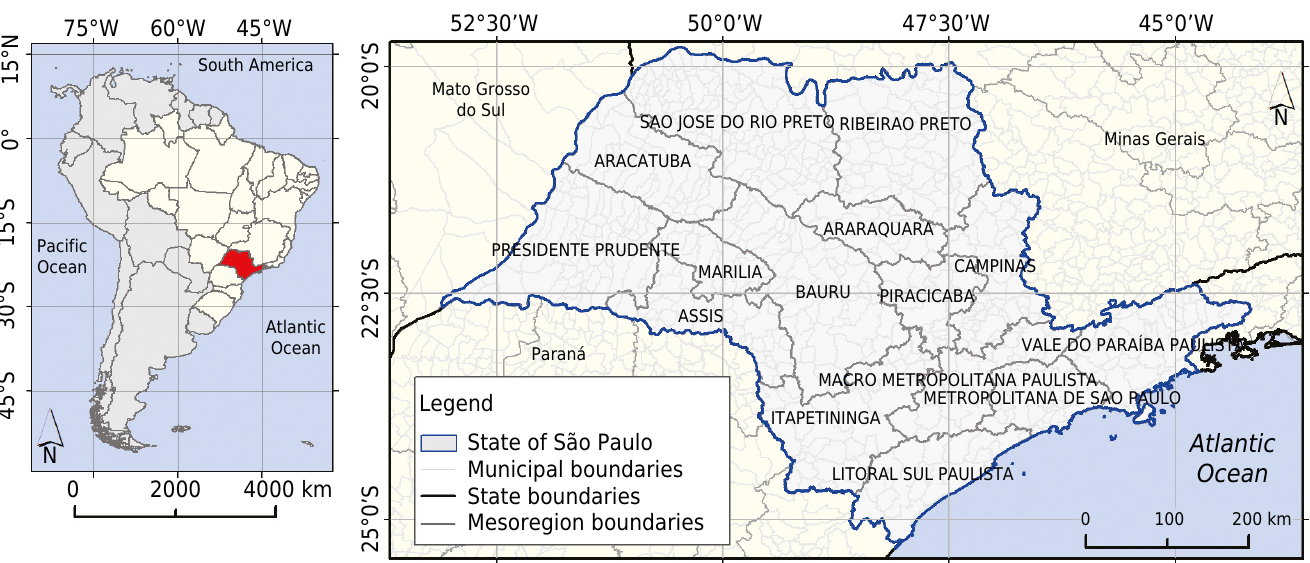
Figure 1. Localization of the study area, state of São Paulo